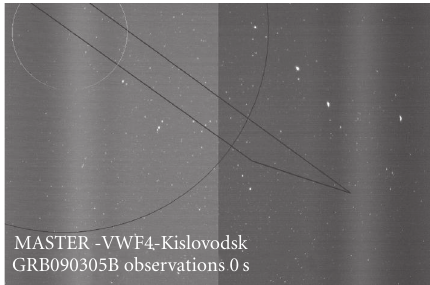
GRB090328B MASTER -VWF2 Irkutsk 0s Figure 21: MASTER-VWF4 follow-up observations of GRB090328B in Kislovodsk. This is a 40 ◦ × 24 ◦ full-frame image. The black circle shows the error box corresponding to the 3 sigma FERMI error limits plus the 3 ◦ systematic error ( R = 12 . 6 ◦